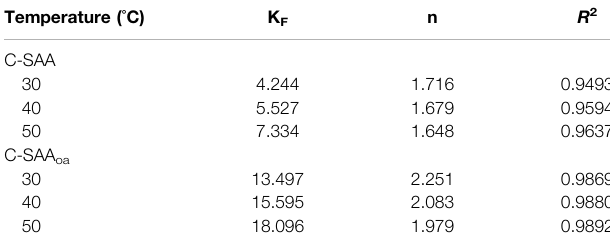
TABLE2| IsothermparametersfortheFreundlichmodelatdifferenttemperatures about C-SAA and C-SAA oa . Temperature ( °